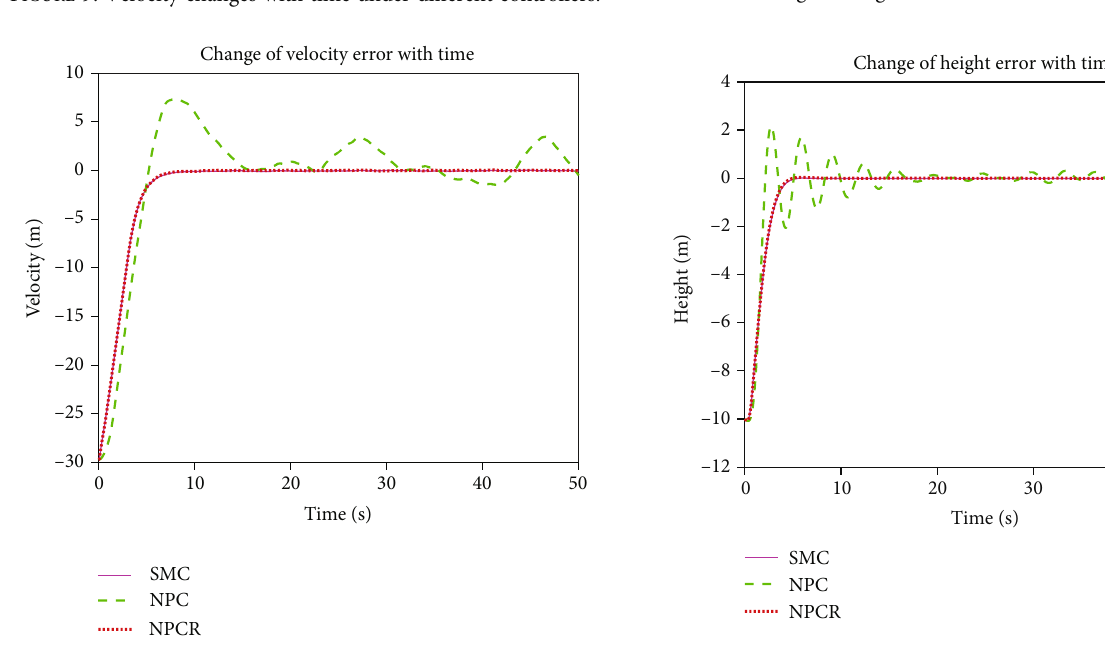
Figure 9: Velocity changes with time under di ff erent